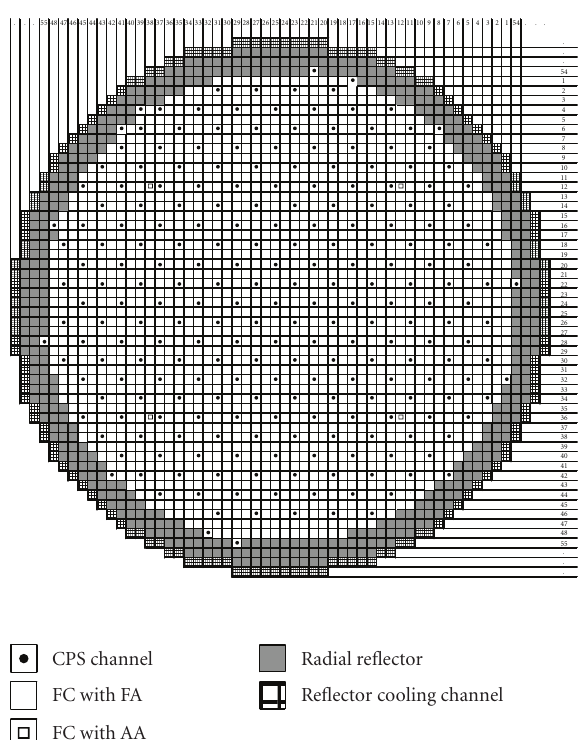
Figure 1: Distribution of fuel channels, CPS channels and graphite reflector cooling channels in the reactor core.